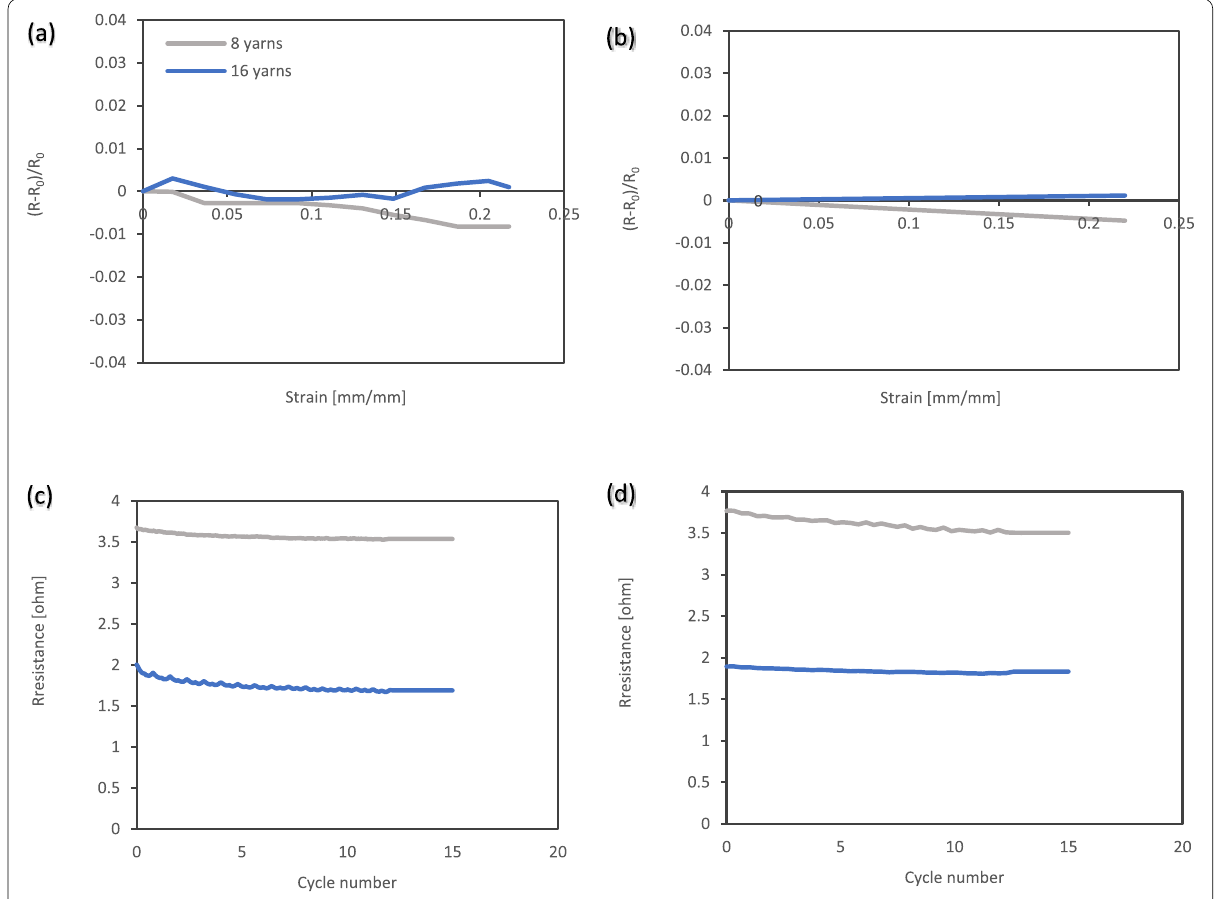
Fig. 15 Measurement of the electrical resistance change of the braided composite at a strain of 22% at a rate of 5 ( a ) and 50 mm/min ( b ); measurement of the resistance during 15 cycles to 22% strain with ( c ) and ( d ) with a rate of 5 and 50 mm/min, respectively